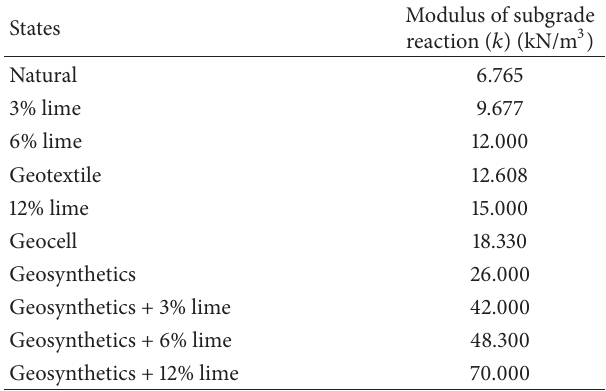
Figure7:Modulusofsubgradereactionwithrespecttolimecontent in the soil.